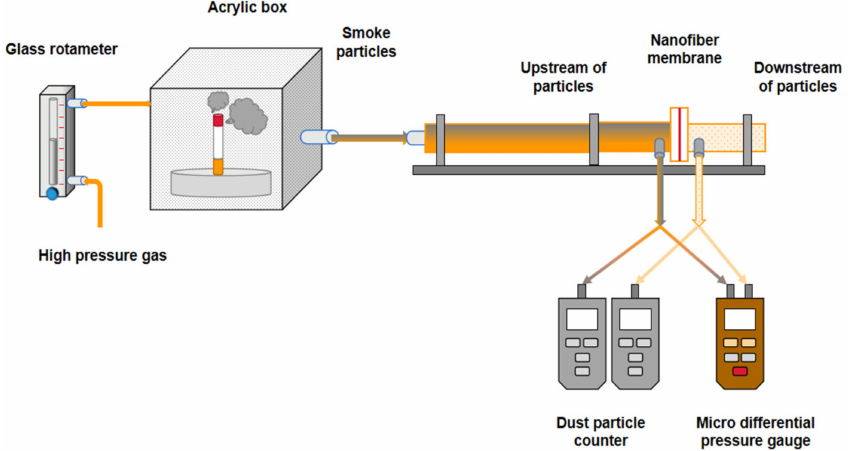
Figure 2. Composite testing device for filtration performance of nanofiber